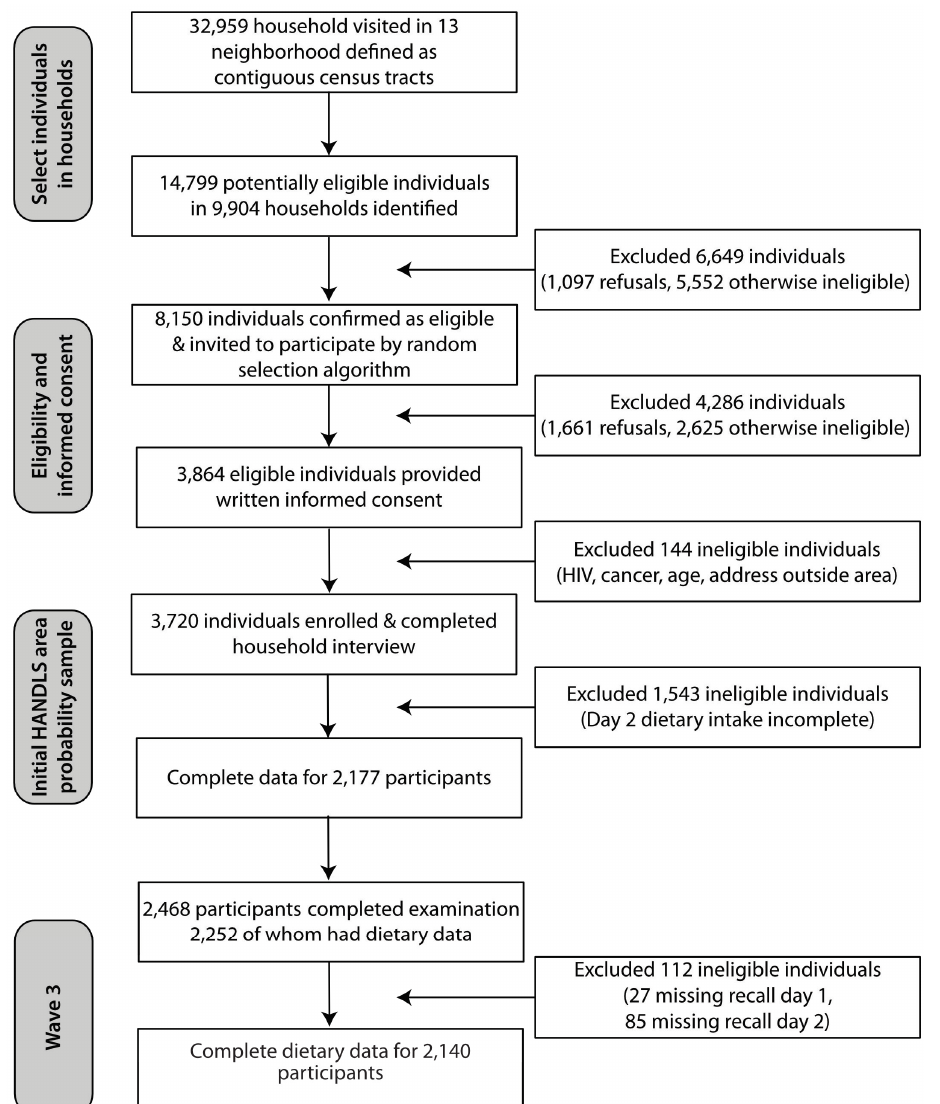
Figure 1. Flow diagram of the Healthy Aging in Neighborhoods of Diversity across the Life Span Study’s household screening, participant eligibility, and response rates.